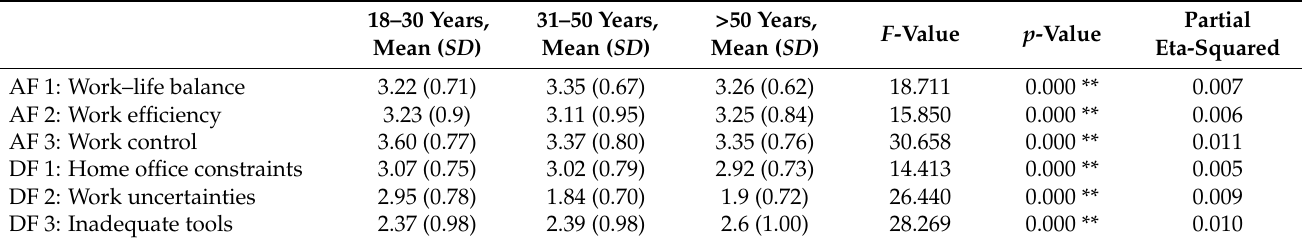
Table 6. ANOVA results for the different age classes.